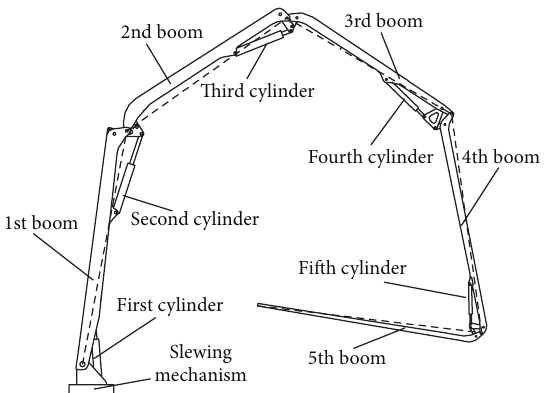
Figure 1: Structural drawing of the boom system.